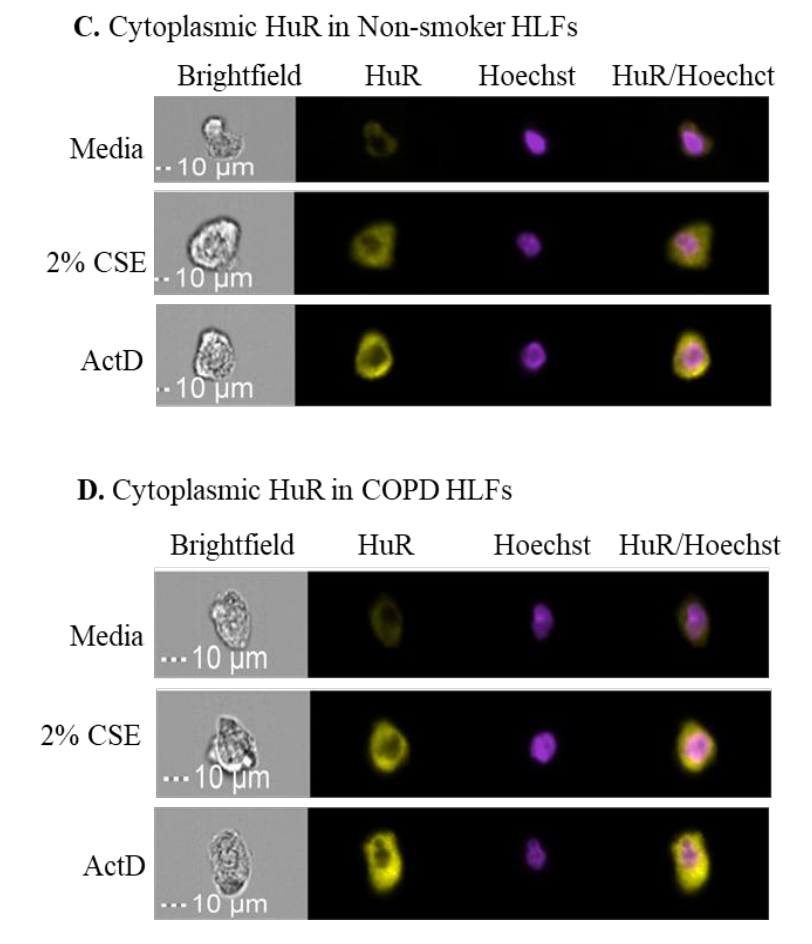
Figure 8. Cytoplasmic HuR is increased by cigarette smoke. ( A ) Cytoplasmic HuR in non-smoker HLFs: there was an increase in HuR cytoplasmic localization in response to 2% CSE for 4 h (** p = 0.004). Actinomycin D (ActD) was used as positive control for the translocation of HuR. Lamin A/C is a nuclear marker, while tubulin is a cytoplasmic marker. Results are expressed as the mean ± SEM